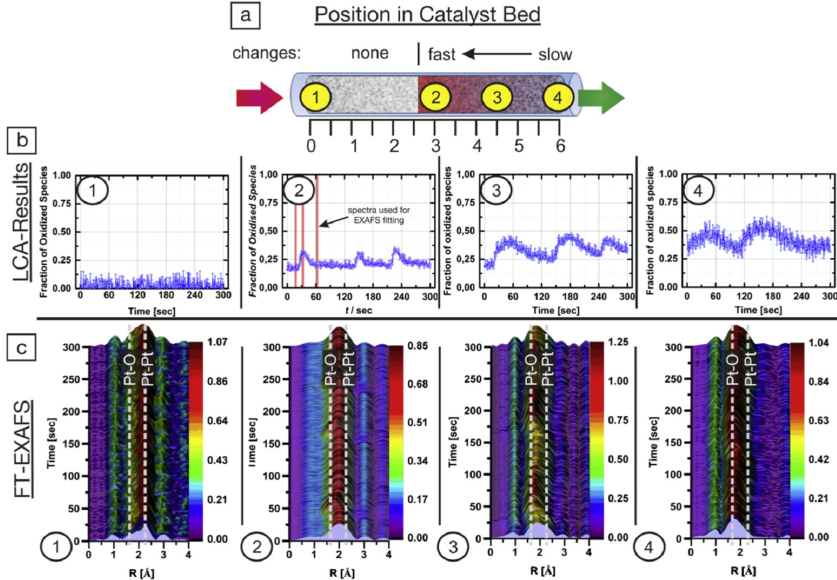
Figure 15. ( a ) Schematic describing both the axial positions used for the acquisition of time resolved Pt L 3 -edge XAFS further described in ( b ) and ( c ) along with indications of the types of temporal change observed during experimentation. ( b ) Results of LCF fitting of the Pt L 3 -edge XANES acquired at each position noted in ( a ) in terms of the fraction of oxidized Pt species present. ( c ) Non-phase corrected Fourier transforms of the k 2 -weighted EXAFS data obtained from Pt L 3 -edge QEXAFS at each position within the bed during oscillatory behavior observed by the MS and located (axially) using imaging thermography. Reproduced with permission from J. Catal. 2015 , 328 , 216–224 [153]. Copyright 2015, Elsevier.